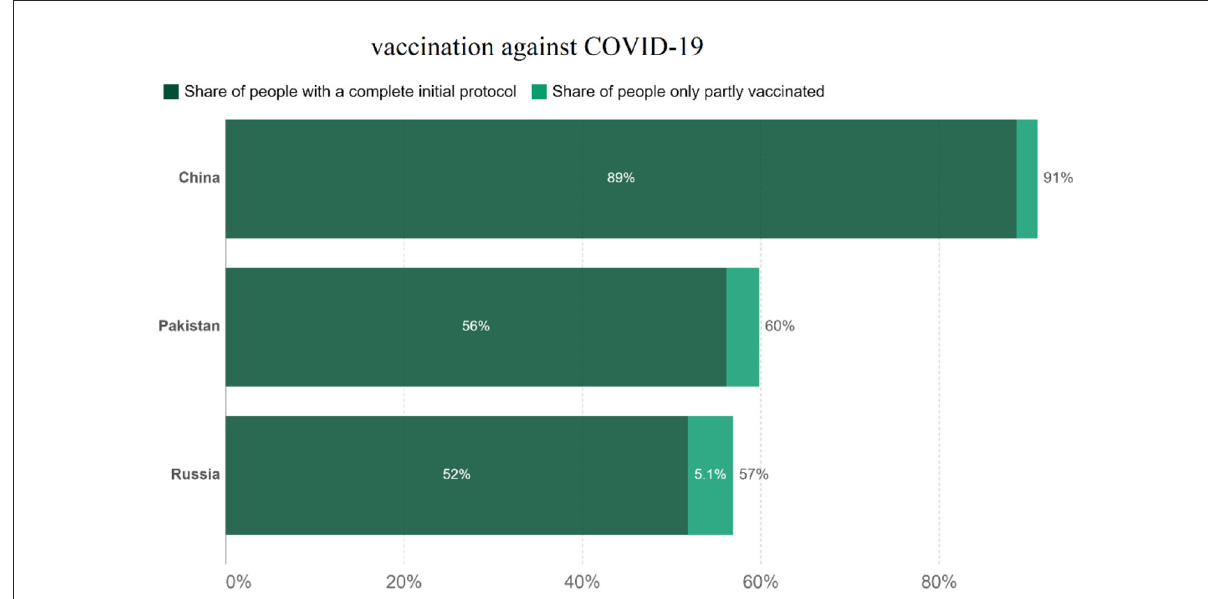
FIGURE6 Share of people’s vaccination against COVID-19. Data source: official data collated by Our World in Data, noted: alternative definitions of full vaccination, e.g., having been infected with SARS-CoV-2 and having one dose of a protocol, are ignored to maximize comparability between countries 14,